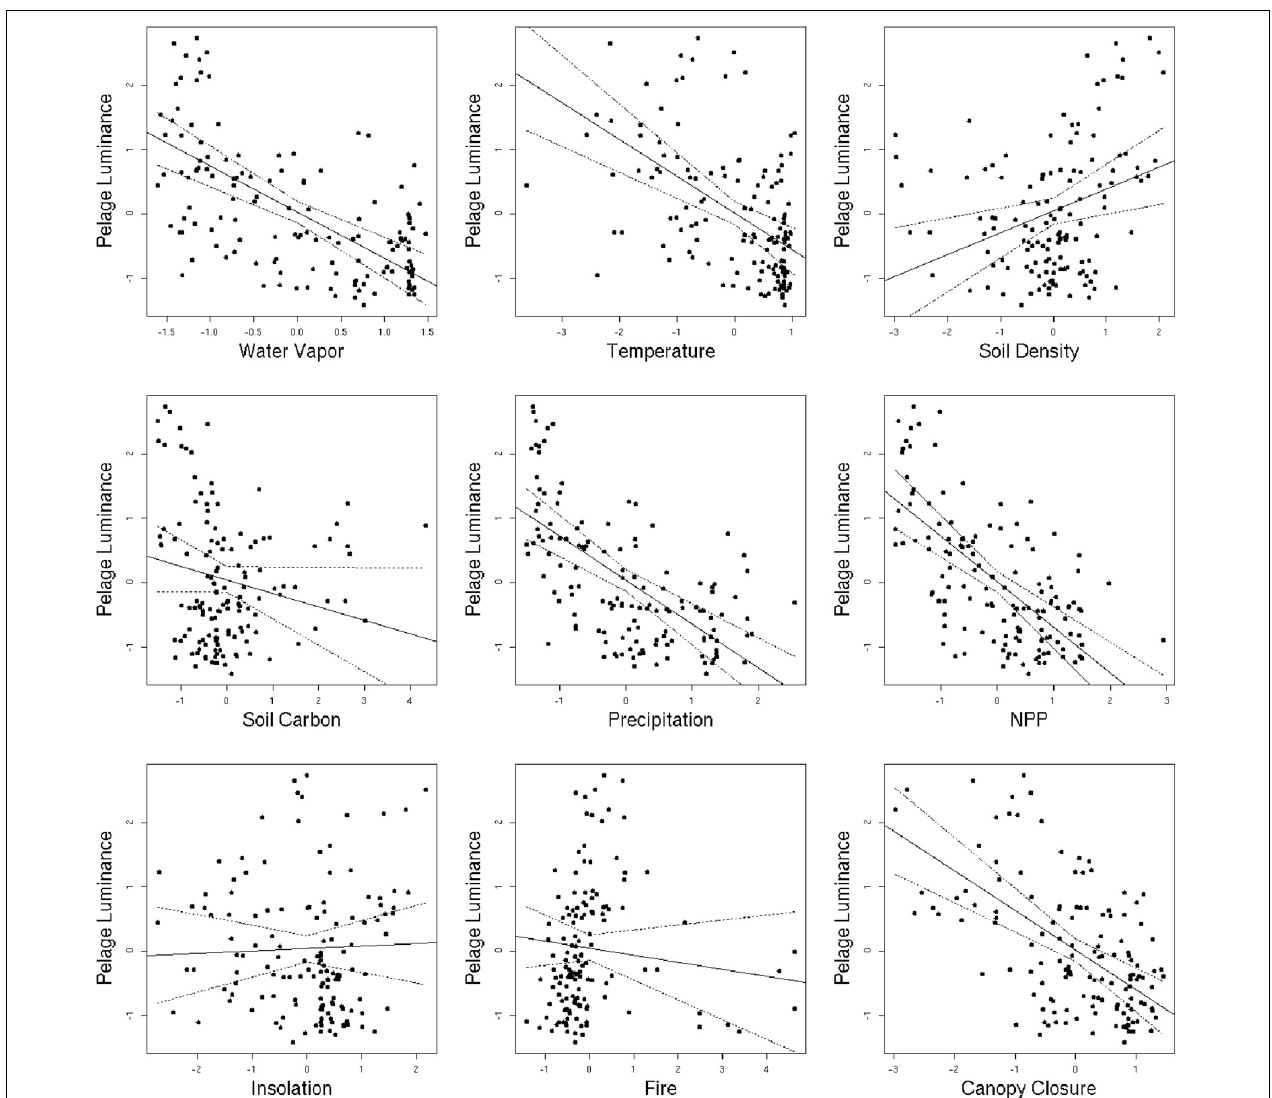
FIGURE 3 | Plots showing the relationship between pelage luminance and each of the nine environmental variables included in this analysis. The solid line represents the line of best fit, while the dashed lines represent 95% confidence intervals from 1000 bootstrap replicates.